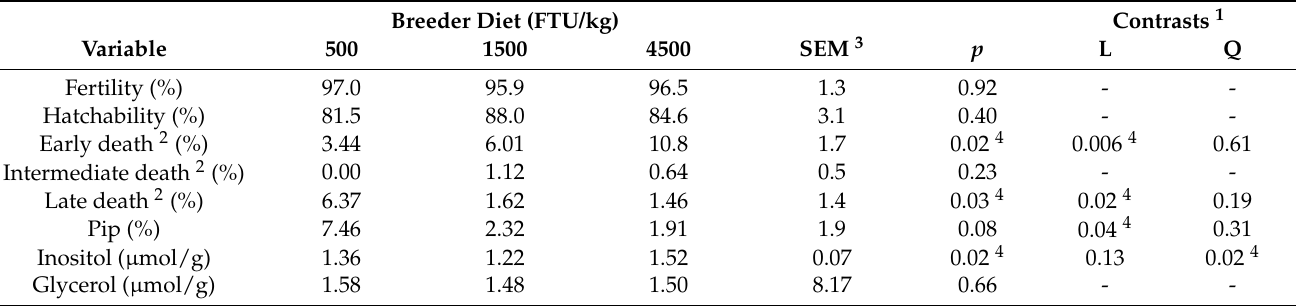
Table 5. Influence of phytase supplementation in 38-week-old breeder diets on progeny quality and yolk sac nutrient concentration on day of